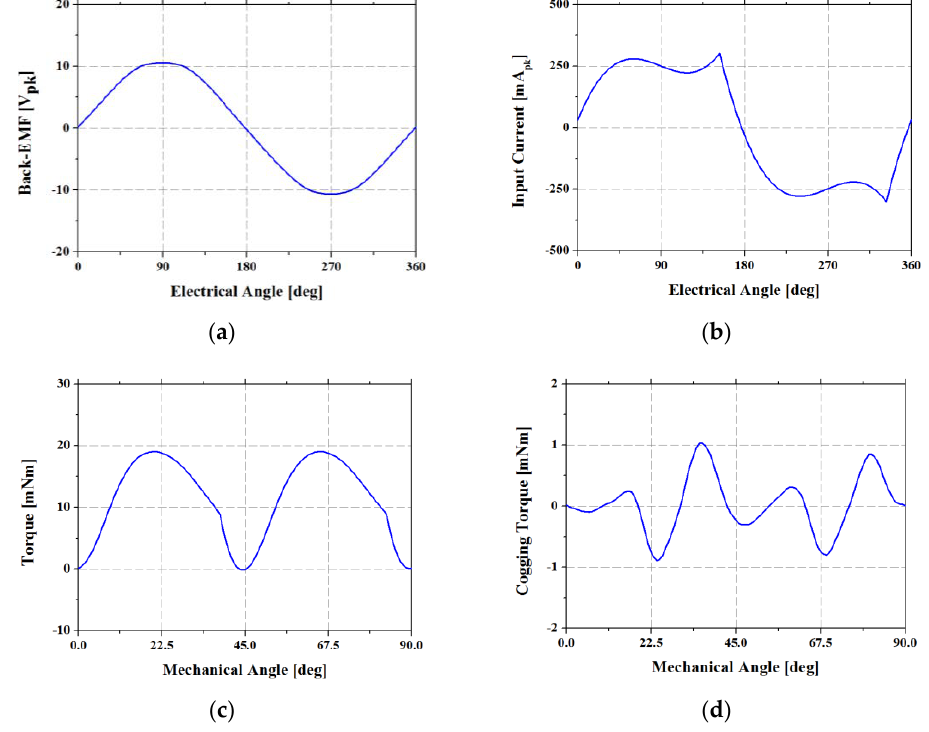
Figure 7. Voltage source analysis of the result of a single-phase claw-pole motor using finite element analysis with the phase advance method: ( a ) waveform of back-EMF; ( b ) waveform of input current; ( c ) waveform of torque; ( d ) waveform of cogging torque.